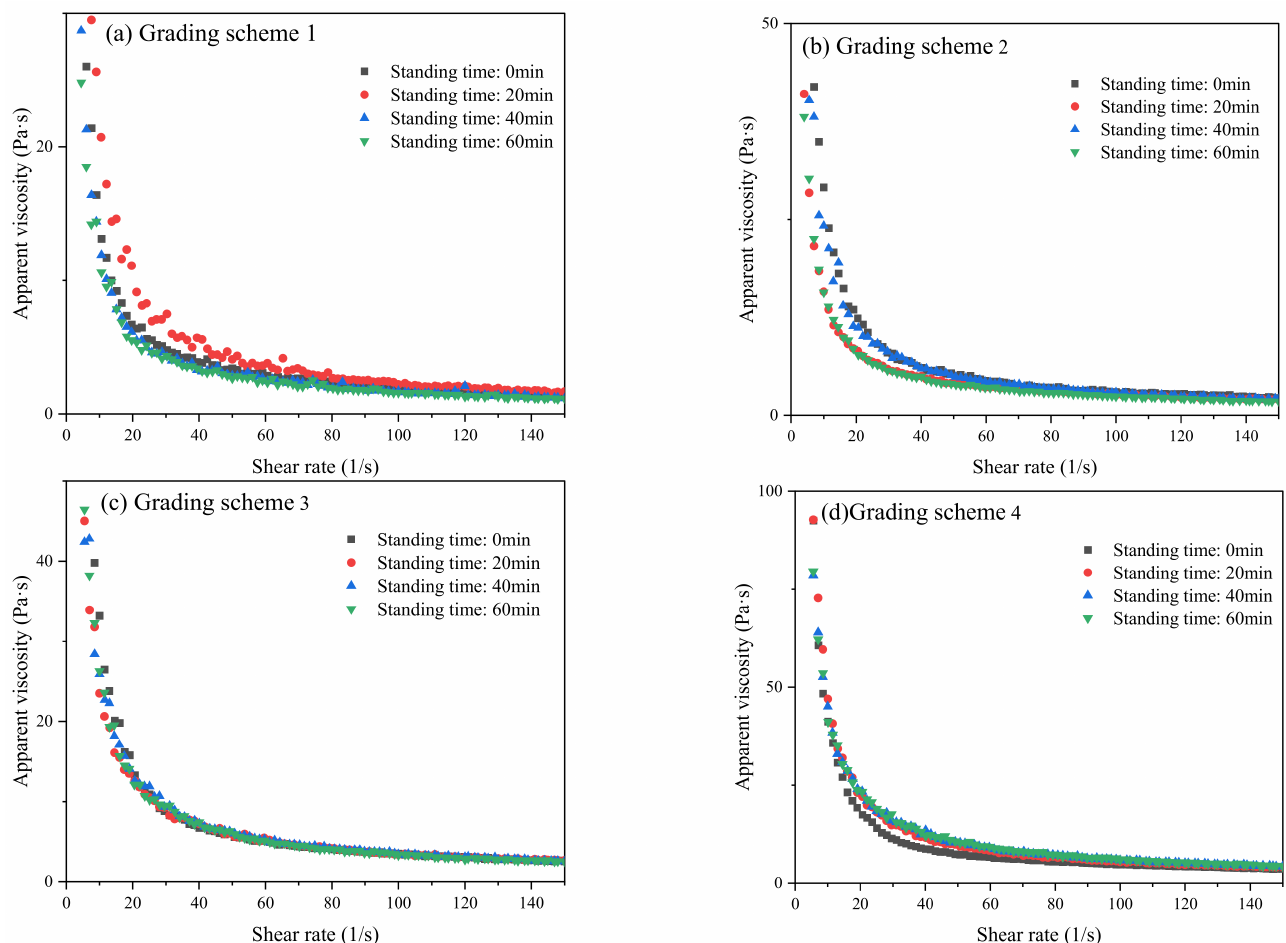
Figure 12. Apparent viscosity & shear rate curve in different grading schemes at 75% mass